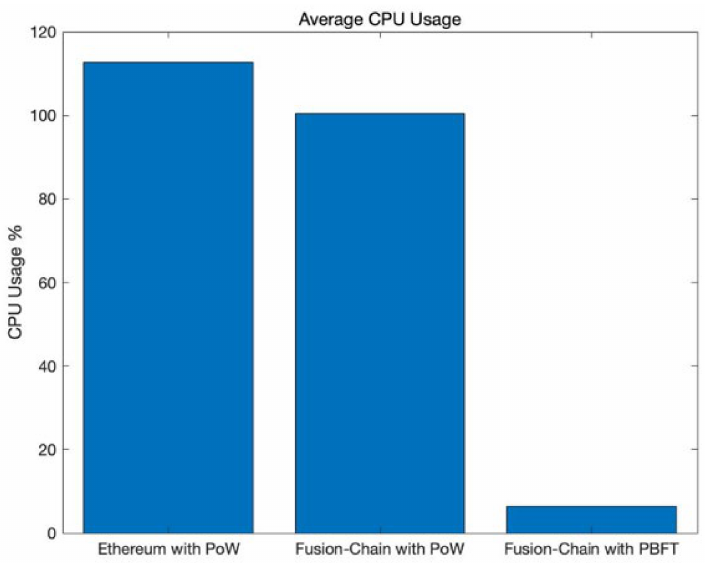
Figure 8. CPU usage comparison.